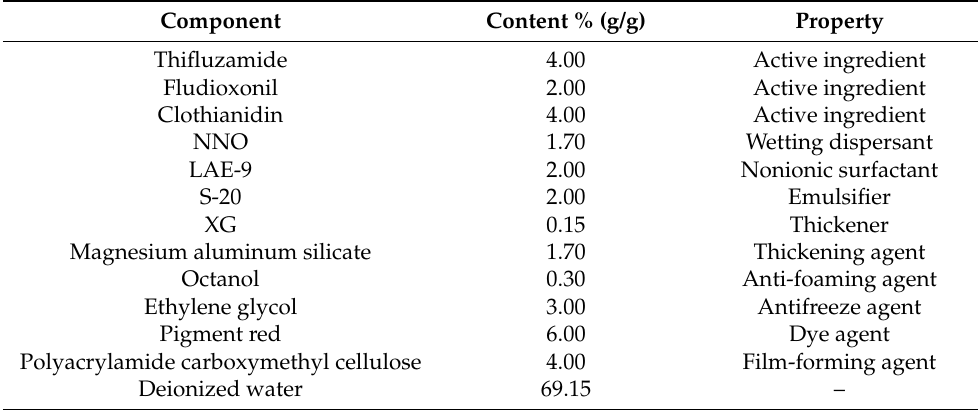
Table 3. Main components of the novel seed coating agent